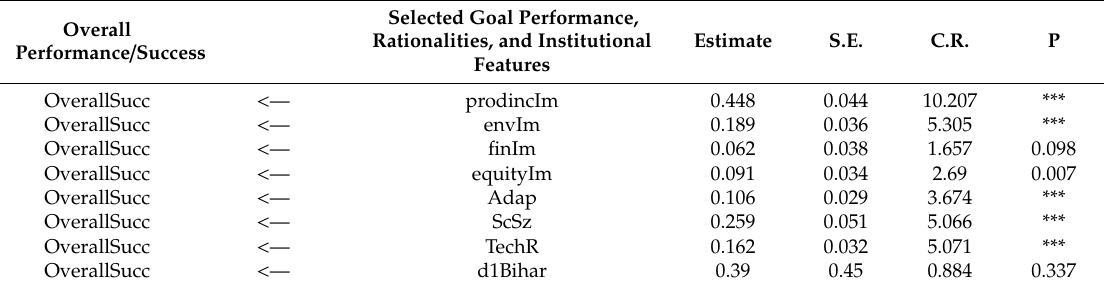
Table 7. Overall success and performance dimensions (Pathway 3–4).